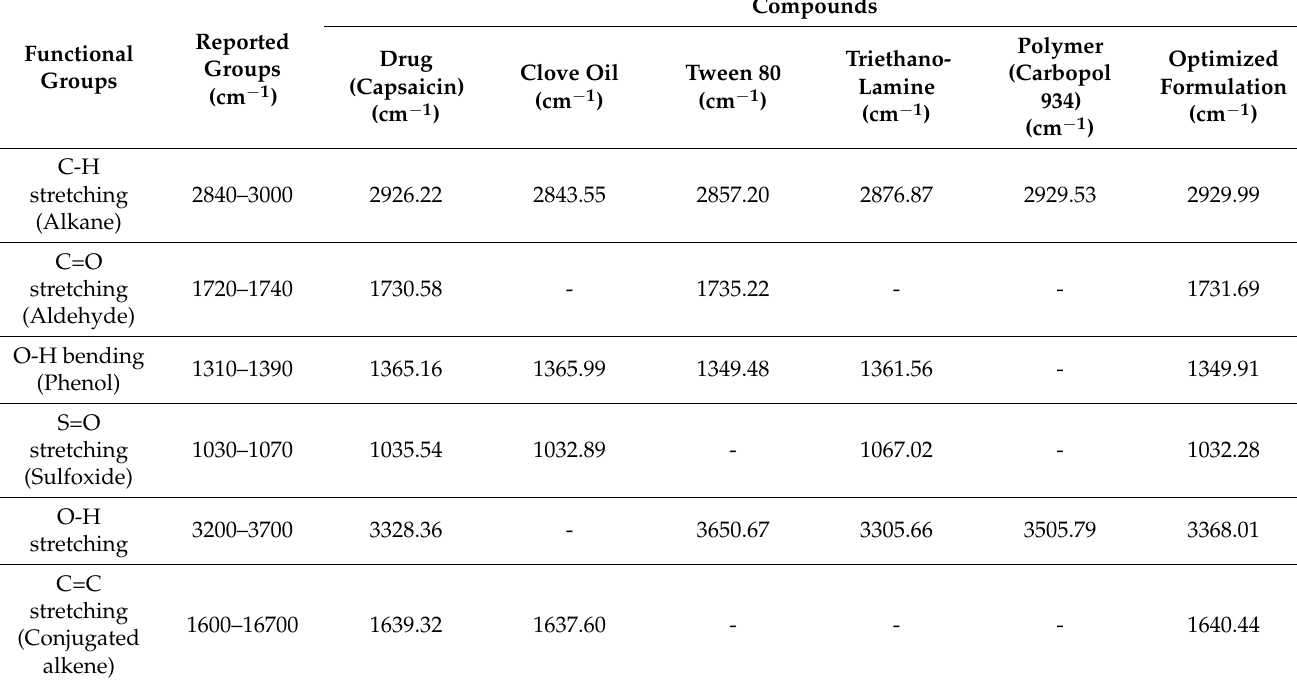
Table 3. Various peaks obtained from FTIR spectra of capsaicin, clove oil, Tween 80, triethanolamine, Carbopol 934, and optimized